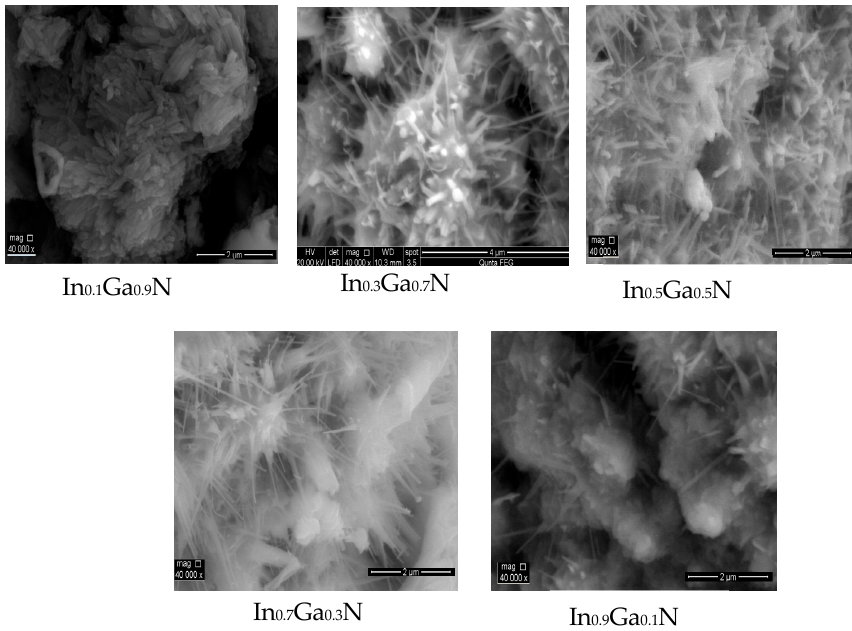
Figure 5. Field emission scanning electron microscopy (FESEM) for bulk alloys at In x Ga 1 − x N heated at 950 ◦ C (0.1 ≤ x ≤ 0.9). Table 2. Measurements of nanowire diameter and length from FESEM for In x Ga 1 − x N bulk alloys.